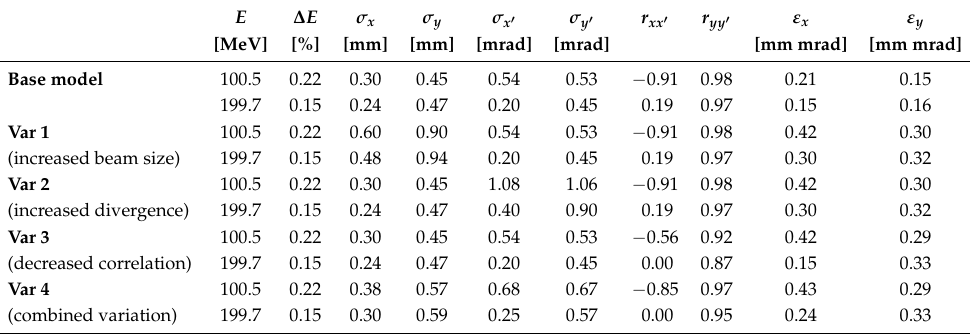
Table 1. The different parametrisation of the virtual beam source. The emittances are given for reference and were not required for the simulation